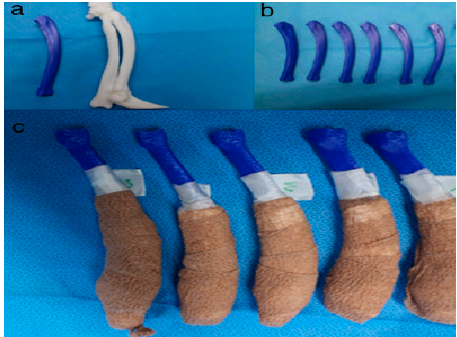
Figure 7. Rapid prototyping bone models were fabricated with the polylactic acid material using the fused deposition modeling method (above, a , b ) and then the phantom bone models were fabricated for this study (below, c ).